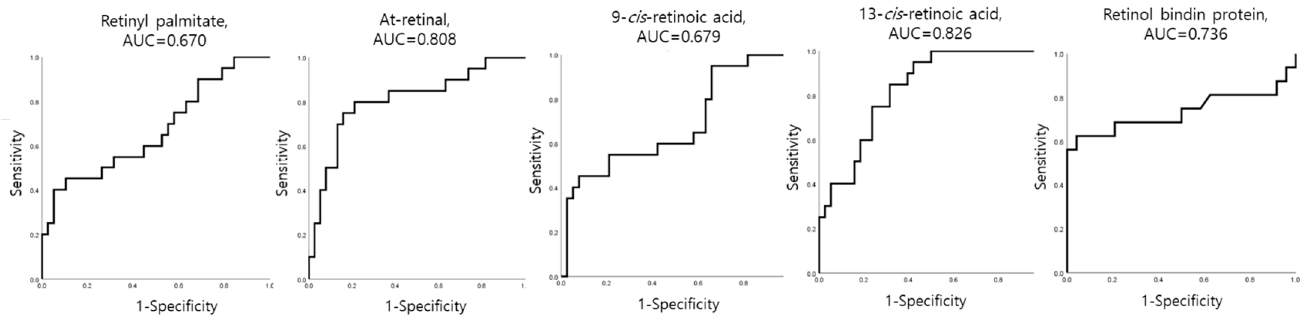
Table 3. Efficacy of retinol-related metabolites for predicting preterm birth.